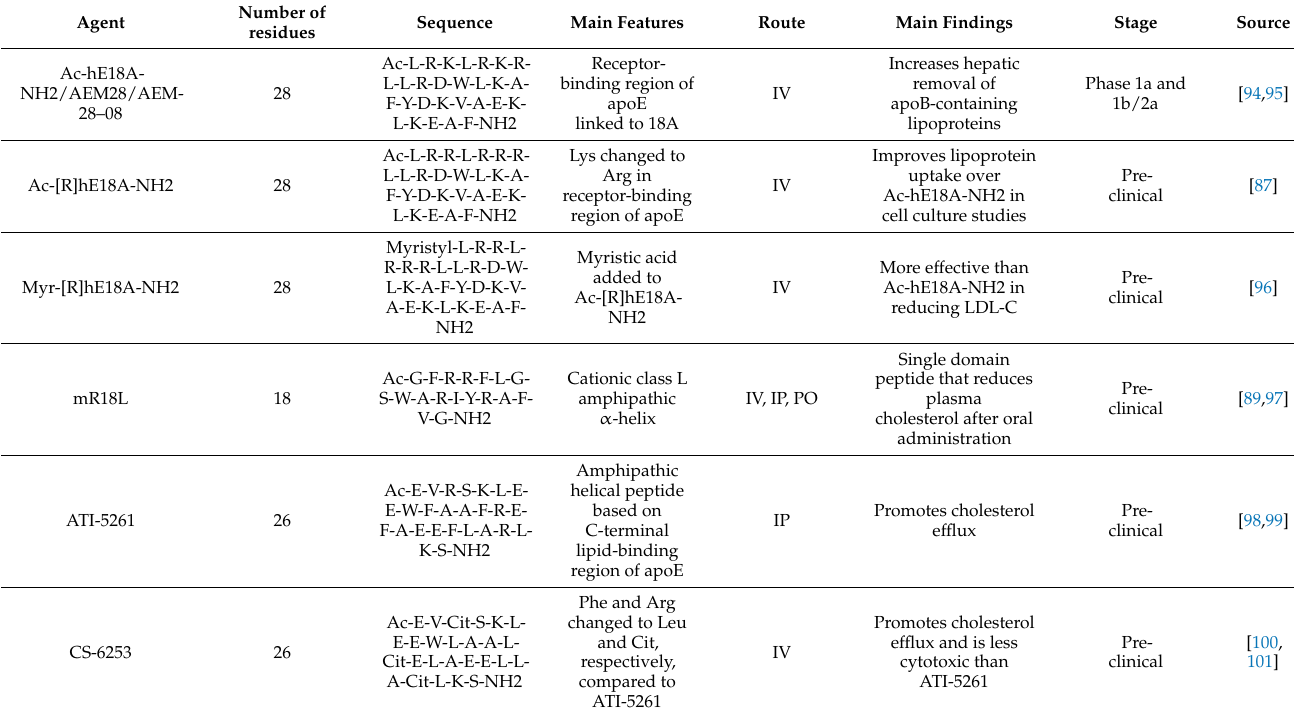
Table 4. ApoE mimetic